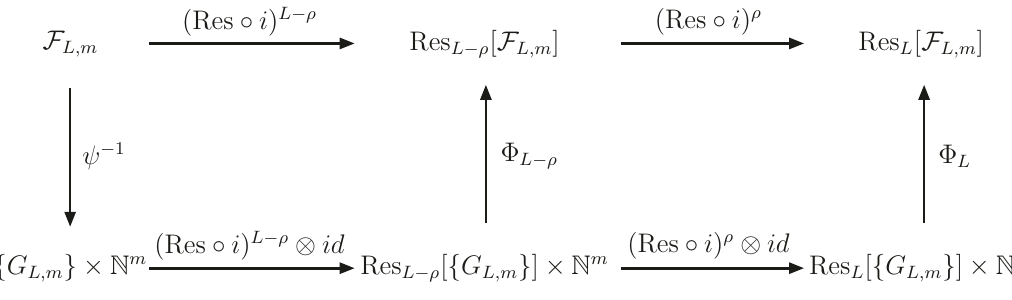
Figure 11 . Algebraic diagram that shows the connection among expressions with simple and multiple poles, after computing the nested